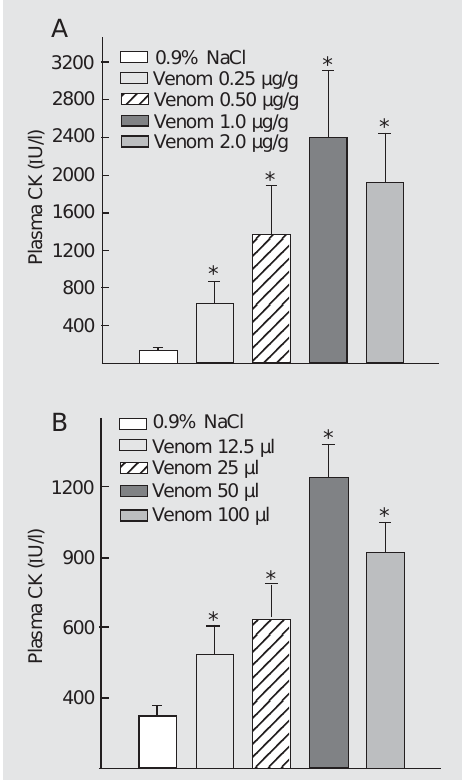
Figure 1. Effects of dose and vol- ume on in vivo myotoxicity of Bothrops jararacussu venom in mice. A , The venom protein dose was increased from 0.5 to 2.0 µg/g in the same volume (50 µl). Plasma creatine kinase (CK) levels were measured 2 h after venom injection. B , Effect of in- jection volume. Venom, 0.5 µg/g was injected in increasing vol- umes, 12.5 to 100 µl, and plasma CK levels were measured 2 h after injection. In both protocols the control group received 50 µl of 0.9% NaCl. Data are reported as means ± SEM (N = 4). *P<0.05 compared to the con- trol group